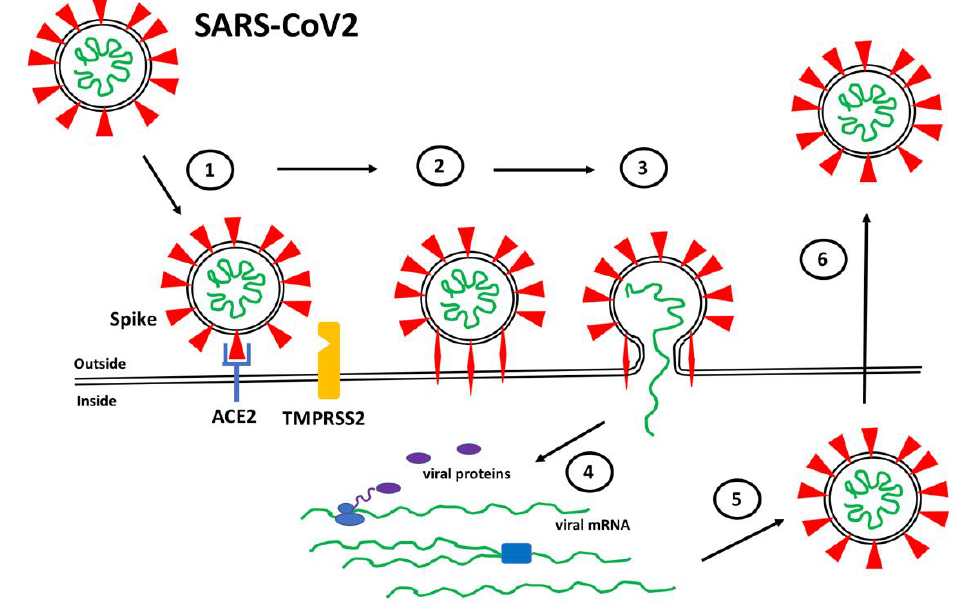
Figure 1. SARS-CoV2 Infection. (1) Spike proteins (red) on the SARS-CoV2 surface bind to ACE2 (blue) on the surface of target host cells. (2) Spike-ACE2 interactions position Spike for proteolytic processing on the cell surface by TMPRSS2 (orange) (or by cathepsin in endosomes after internaliza- tion). Cleavage of Spike releases a structural constraint that allows Spike to convert to its “fusion” structure that penetrates the host cell membrane. (3) “Fusion” Spike facilitates fusion between the viral and host membranes, allowing entry of viral RNA. (4) Viral RNA is translated and replicated within the host cell. (5) New virus particles are packaged in the host cell where furin cleaves Spike so as to prime it for later conversion to the “fusion” structure. (6) New SARS-CoV2 particles are released (or transferred to adjacent fused cells) to propagate further host cell infection.